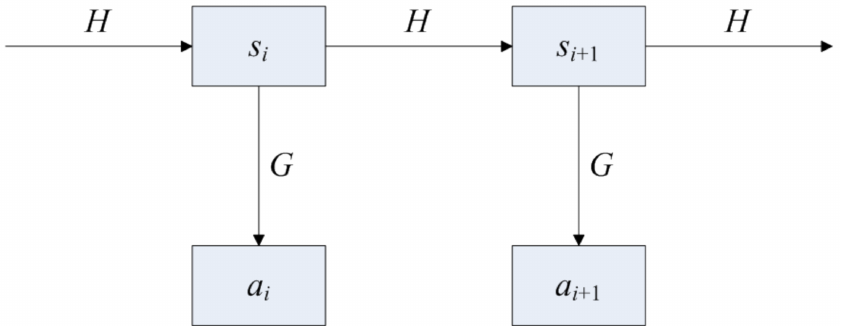
Figure 4. Safety mechanism of radio frequency identification